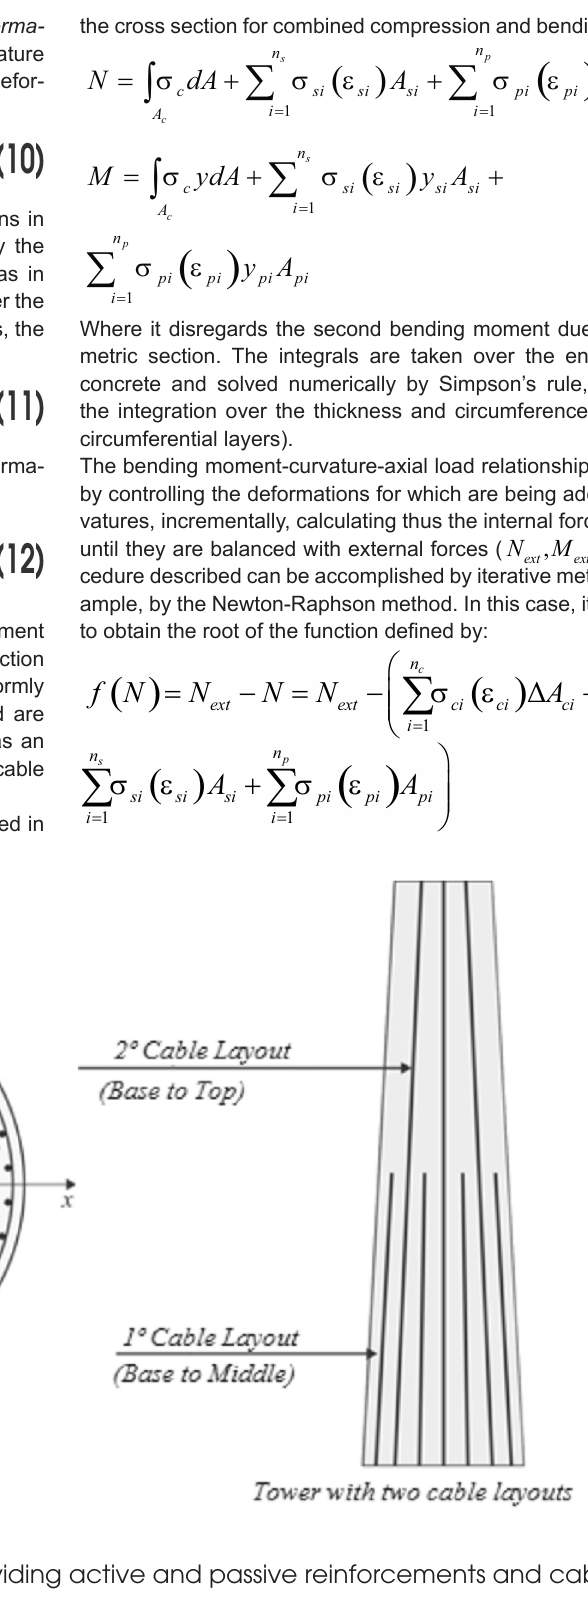
Schematic diagram of anular cross section providing active and passive reinforcements and cable layouts along the